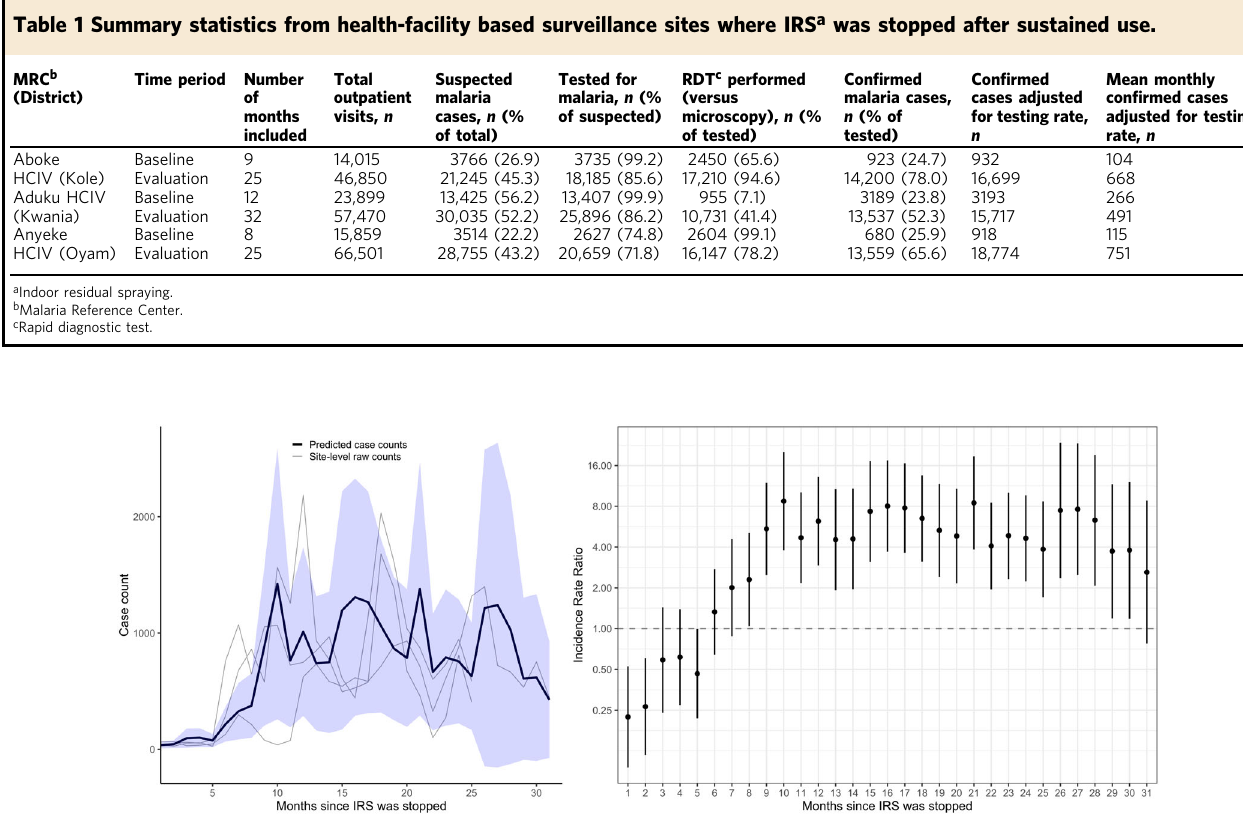
Fig. 3 Predicted case counts and adjusted incidence rate ratios (IRR) from multilevel negative binomial model assessing the impact of withdrawing indoor residual spraying (IRS) after 5 years of sustained use. The blue shaded region on the left represents the 95% con fi dence interval around the mean predicted case counts across sites from the adjusted regression model. Gray lines represent observed monthly case counts from individual sites. On the right, vertical bars represent the 95% con fi dence interval around the adjusted IRR (the measure of center for the error